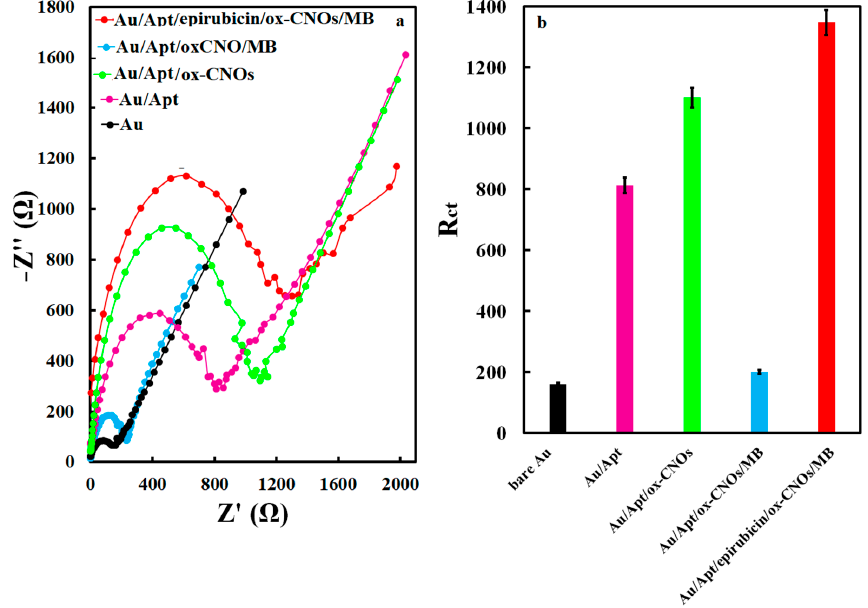
Figure 5. ( a ) Nyquist plots of different electrodes in 1 mM K 3 [Fe(CN) 6 ]/K 4 [Fe(CN) 6 ] solution and ( b ) the obtained R ct value of different electrodes.